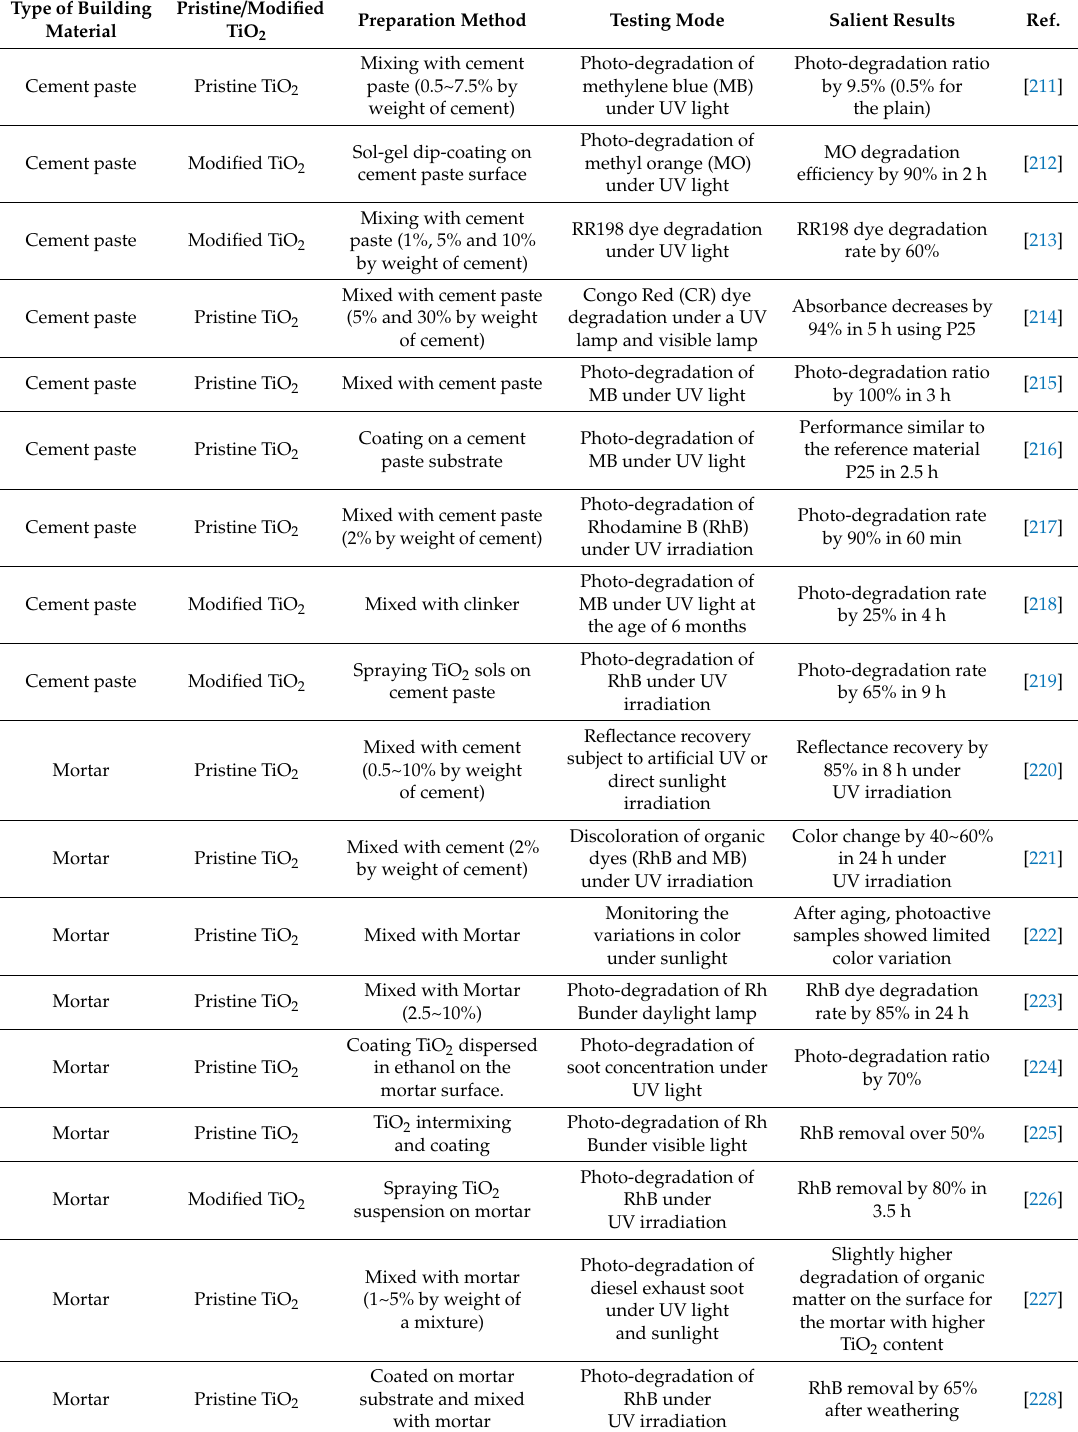
Table 3. Summary of various TiO 2 based pristine / modified building materials having self-cleaning properties, their preparation route, and salient